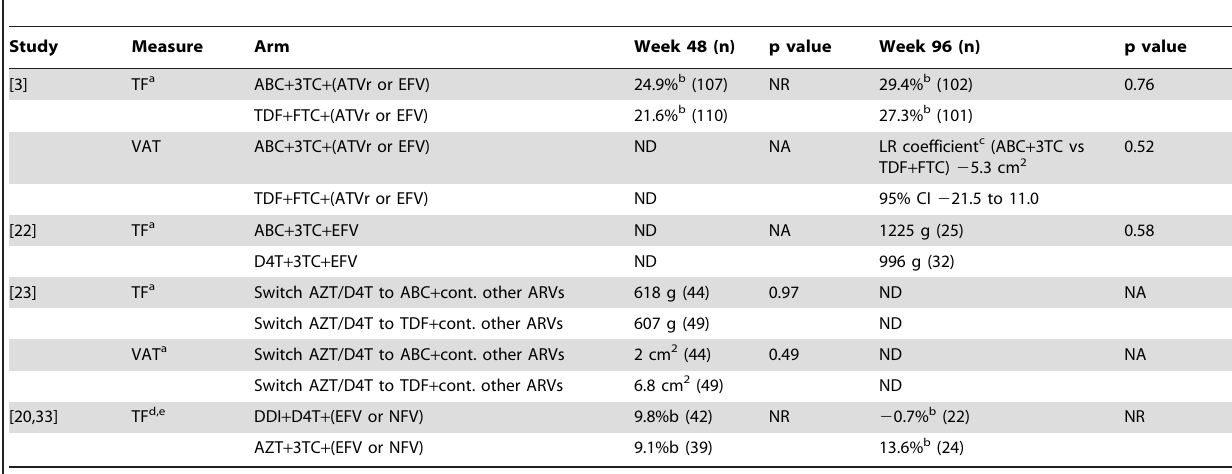
Table 14. Change from baseline in trunk fat (TF) on DEXA scan, and visceral adipose tissue (VAT) on CT scan: NRTI versus NRTI.